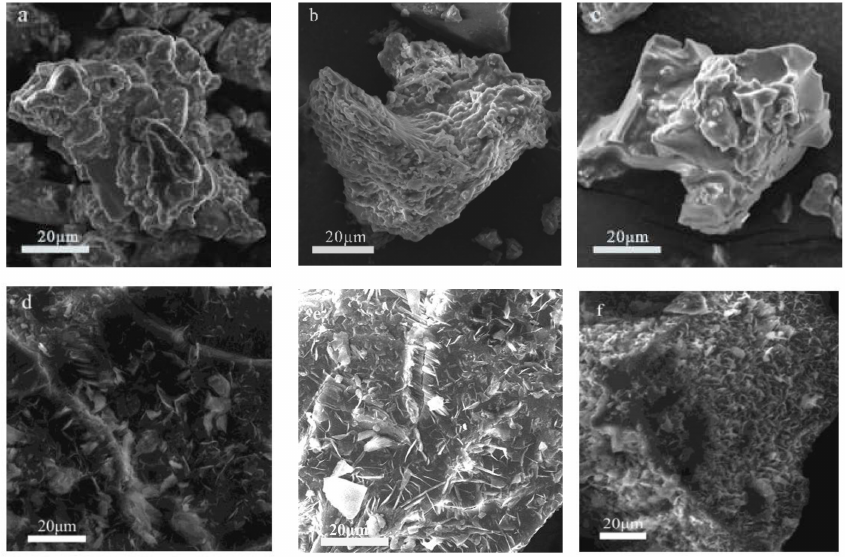
Figure 2. SEM micrographs of the samples: ( a ) 0.75Cu-Mg-Al N; ( b ) Cu-Mg-Al N; ( c ) 1.25Cu-Mg-Al N; ( d ) 0.75Cu-Mg-Al DS/N; ( e ) Cu-Mg-Al DS/N; ( f ) 1.25Cu-Mg-Al